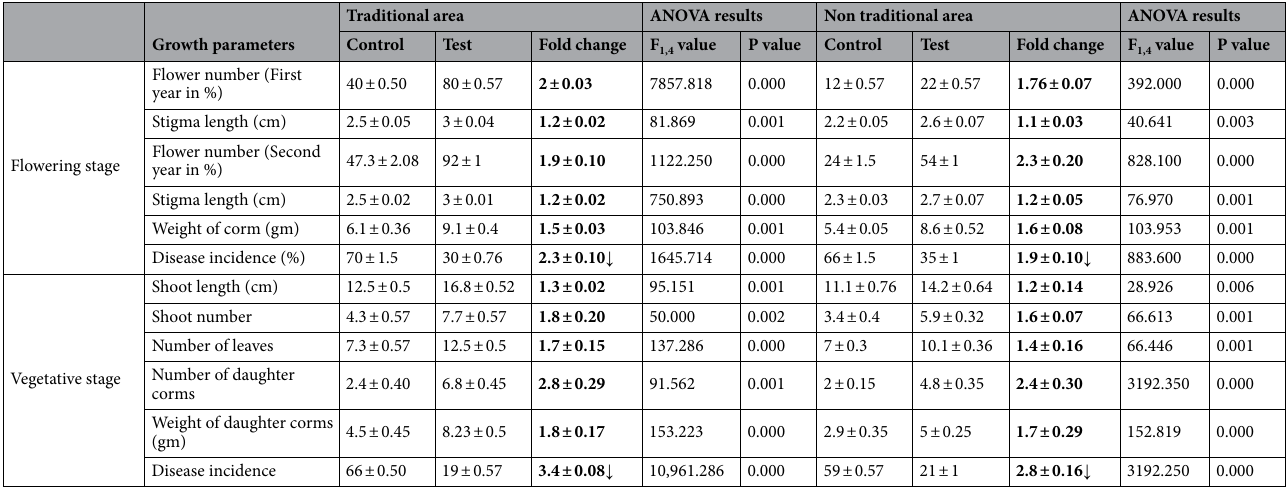
Table 2. Field evaluation of Bar D5 based bio-formulation during the flowering and vegetative stage of saffron life cycle. Bold values highlight the infrence between the control and test sample.